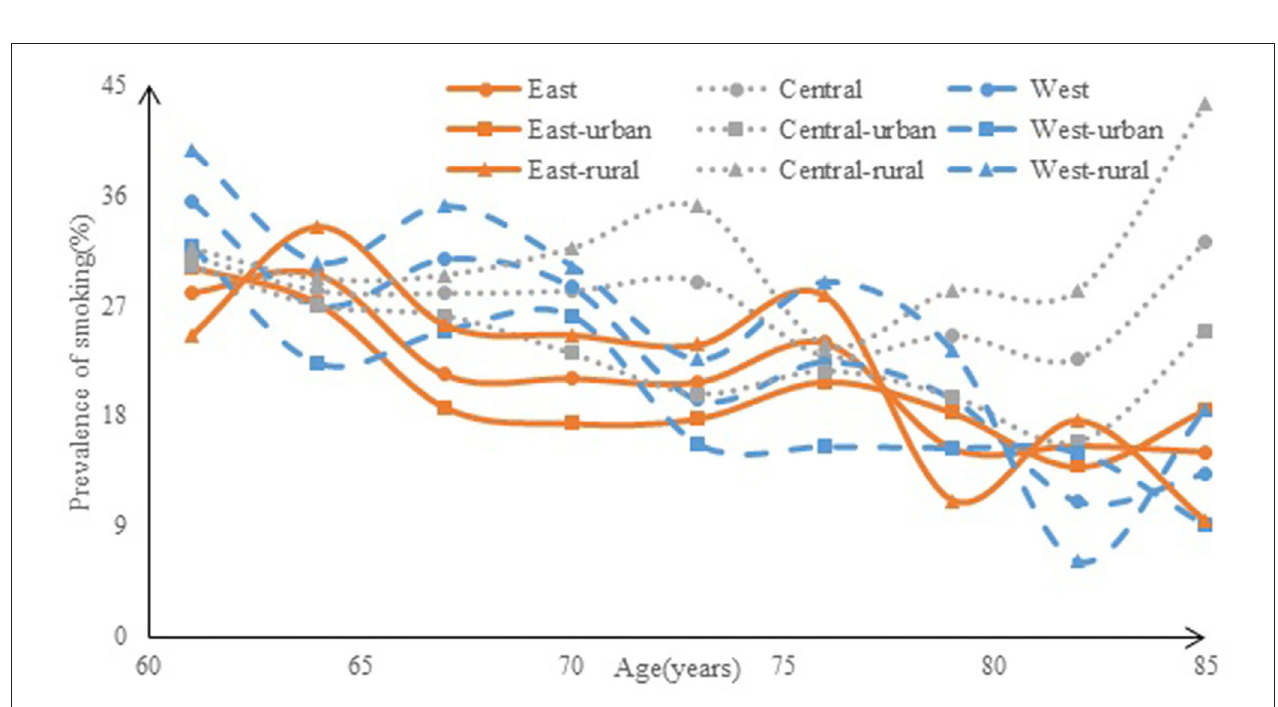
FIGURE 3 | The prevalence of smoking among the elderly by region.